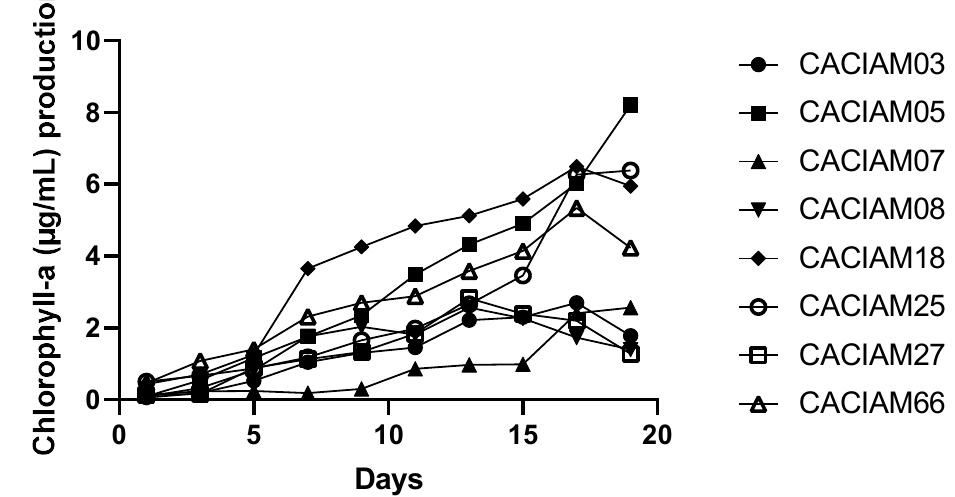
Figure 1. Growth curve by extraction of chlorophyll a from cyanobacteria strains. Data are mean values of three replicate cultures.